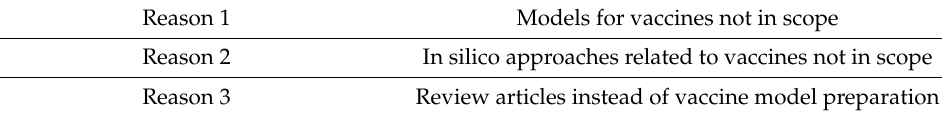
Table 2. Reasons to exclude identified